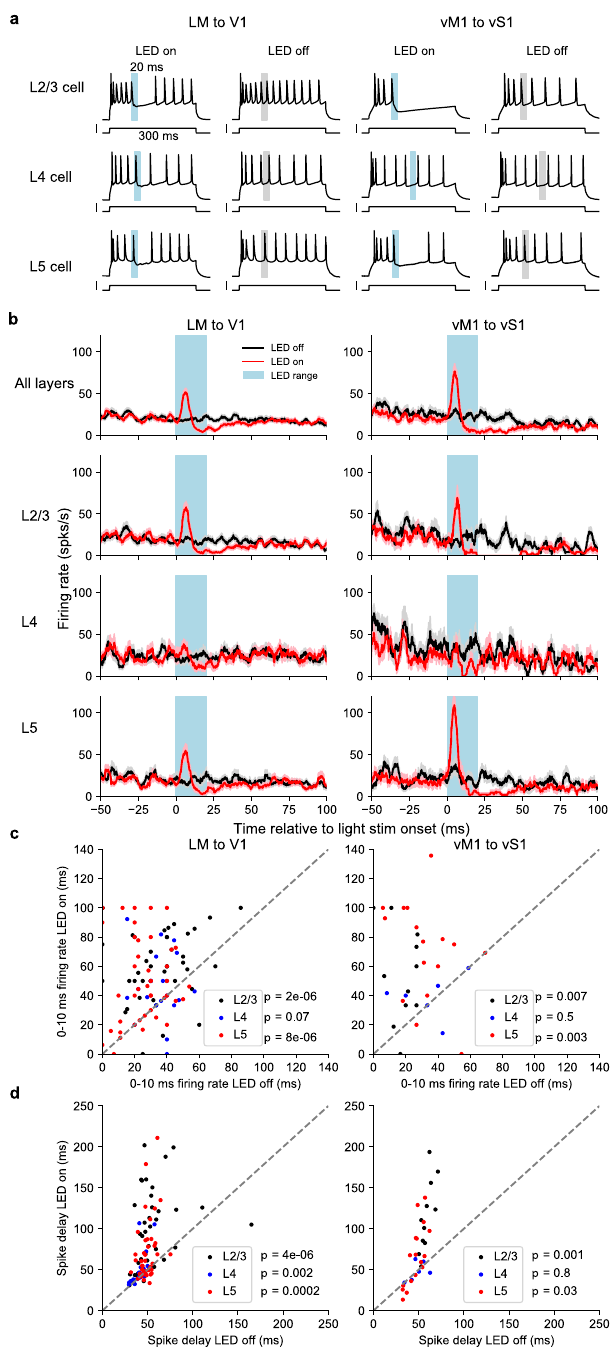
Fig. 4 | Feedback activity temporally sharpened the fi ring patterns of pyr- amidal cells in V1 or vS1 in both feedback pathways. a Examples of feedback modulation on the fi ring patterns of pyramidal cells in L2/3(top), L4 (middle),and L5 (bottom) of V1 (left) or vS1 (right). Cells were driven to fi re with sustained positivecurrentinjection.InLED-ontrials(leftplots),20msLEDstimulus(bluebar) was delivered. LED-off trials (right plots) were paired with the LED-on trials. Gray bars mark the LED stimulus range of the corresponding LED-on trials. b Peristimulus time histogram of pyramidal cells for feedback on trials (red, solid line: mean, shade: s.e.m across cells, same for later)and feedback off trials (black). c Firingrateinfeedbackofftrialsvsfeedbackontrialswithinthetimerangeof0to 10ms after the LED onset for pyramidal cells in L2/3 (black dots, 44 cells over 15 animals for V1 and 11 cells over 2 animals for vS1), L4 (blue dots, 20 cells over 7 animals for V1 and 6 cells over 2 animals for vS1) and L5 (red dots, 45 cells over 15 animals for V1 and 17 cells over 6 animals for vS1). p values are from the two-sided Wilcoxon sign-rank tests. d Time delay relative to the LED onset of the fi rst spike after LED offset (i.e. after 20ms) in feedback-on trials vs feedback-off trials for pyramidalcellsinL2/3(blackdots,44cellsover15animalsforV1and11cellsover2 animals for vS1), L4 (blue dots, 20 cells over 7 animals for V1 and 6 cells over 2 animals for vS1) and L5 (red dots, 45 cells over 15 animals for V1 and 17 cells over 6 animals for vS1). p values are from the two-sided Wilcoxon sign-rank tests. Source data are provided as a Source Data fi